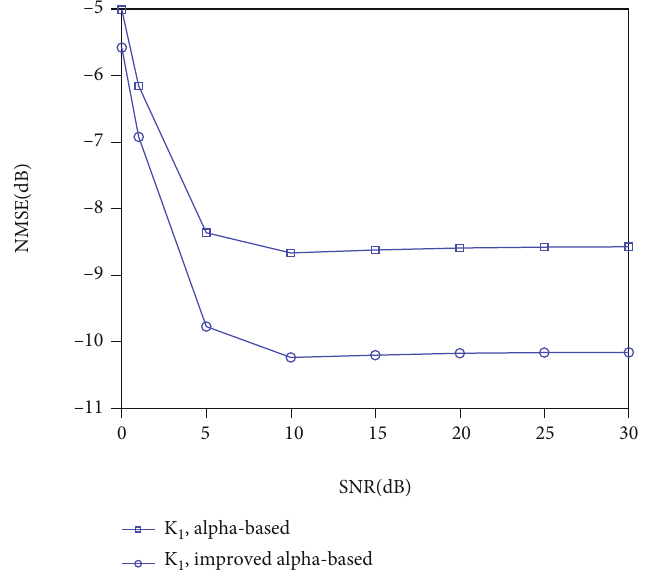
Figure 6: Normalized mean square spectrum estimation error vs. SNR using the Fourier basis and both the simple and improved alpha-based methods, compression ratio is 8/21 ( K 1